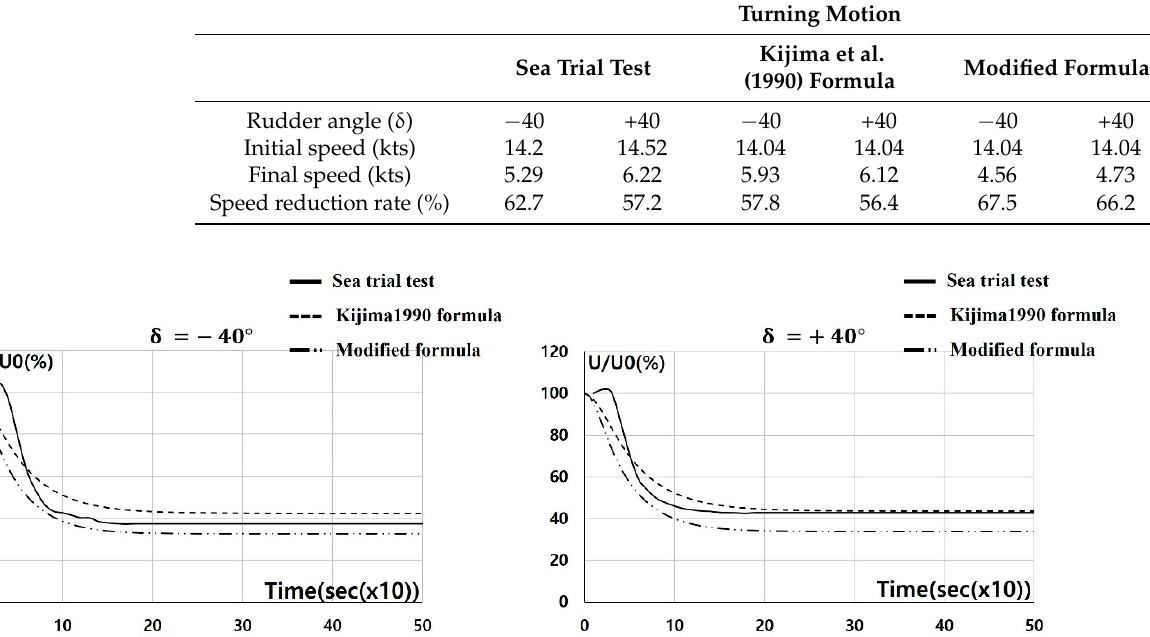
Figure 8. Comparison of the speed deceleration rate during the turning motion of the target trawler (where U is the speed for each section and U0 is the initial speed).